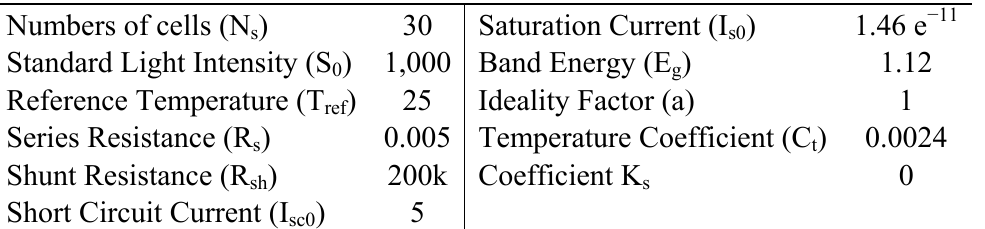
Table 3. Parameters of the PV panel.